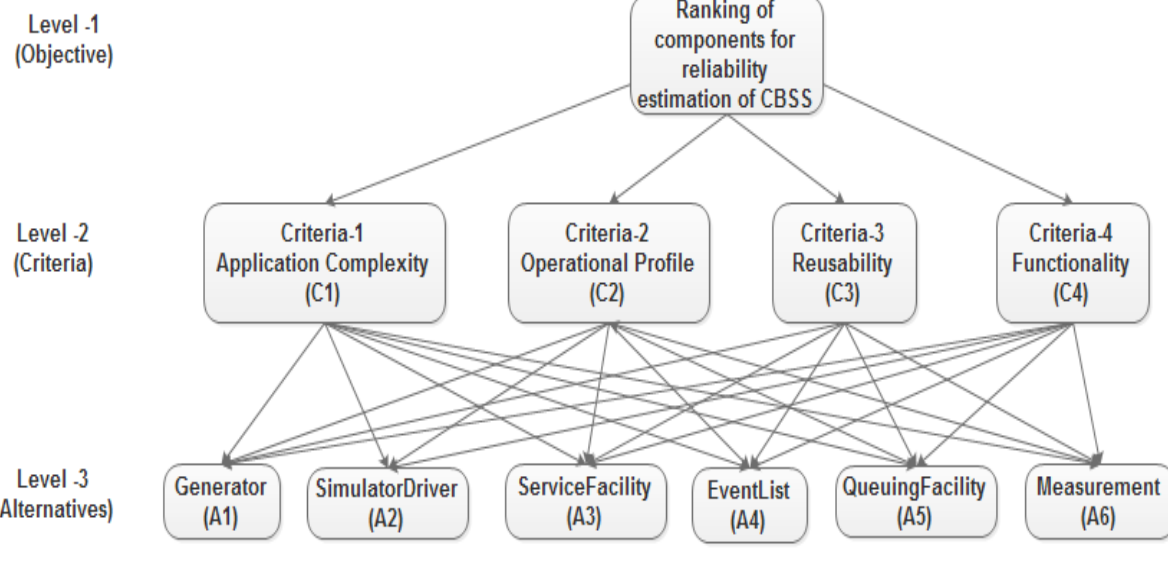
Fig. 4. WQS reliability estimation problem hierarchy